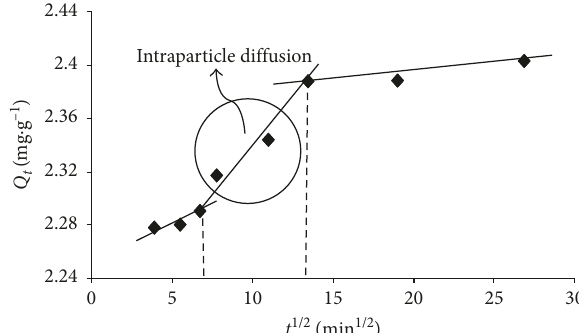
Figure 4: Intraparticle diffusion plot for the sorption of Tb(III) metal